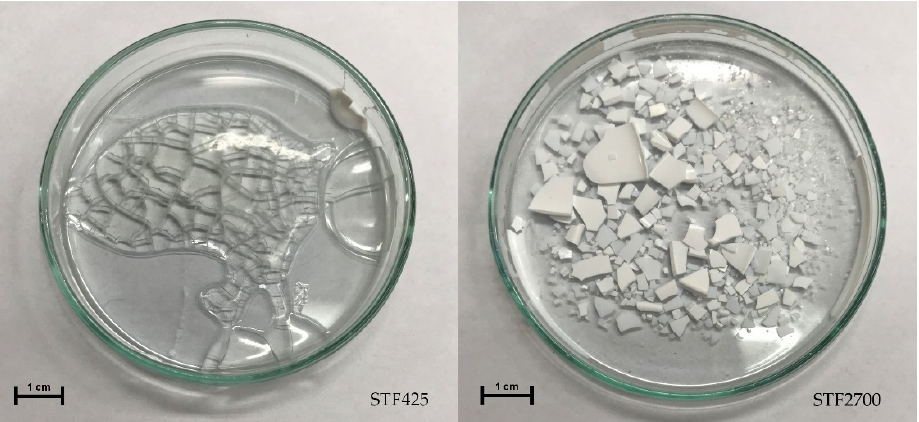
Figure 4. Samples of STFs after aging.